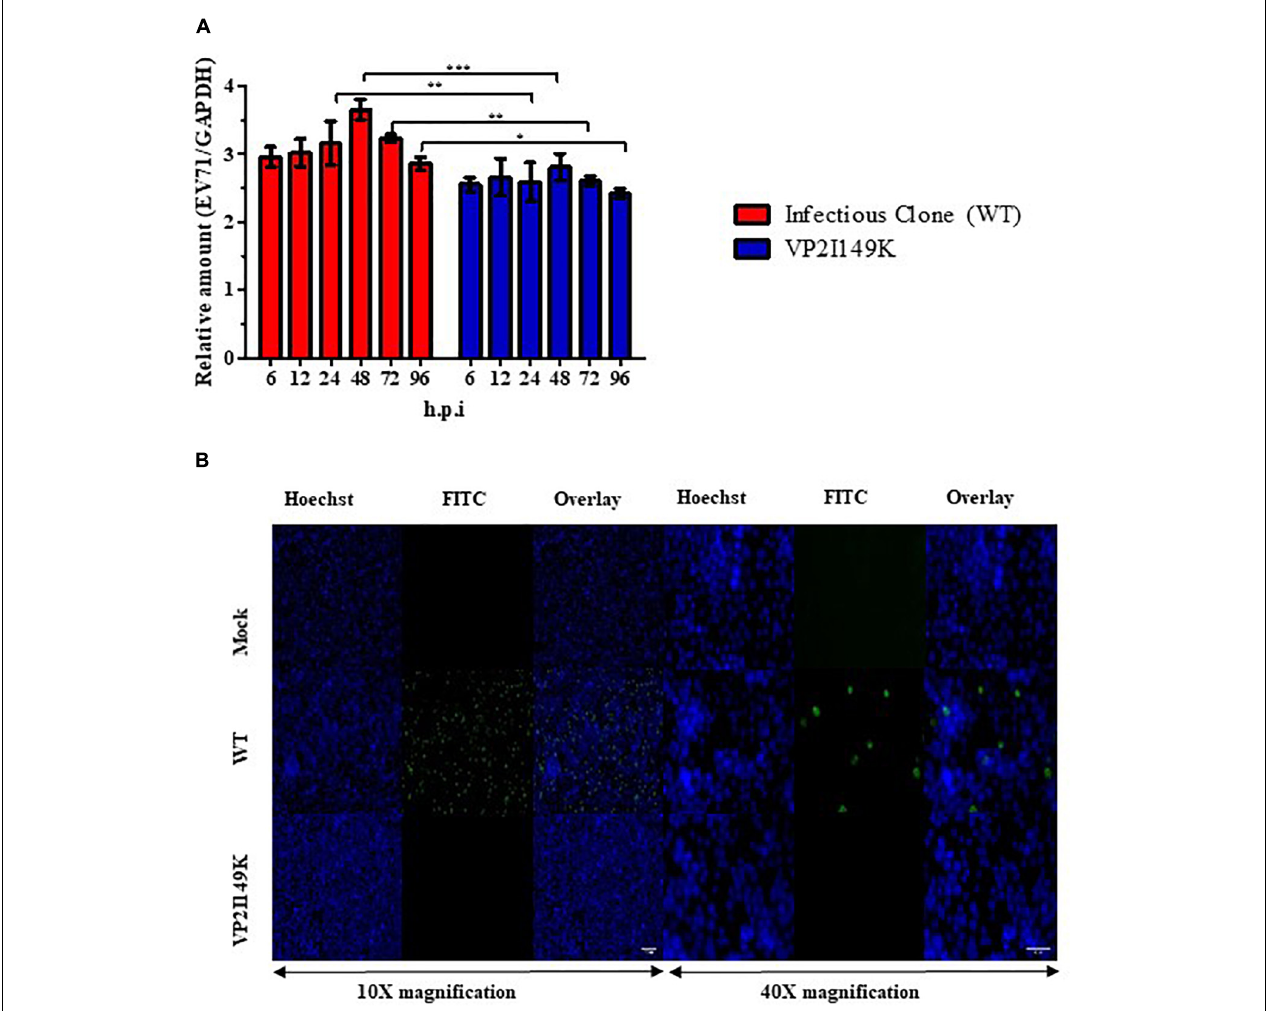
FIGURE 2 | Replication of VP2 I149K mutant in NSC-34 cells. (A) Quantification of intracellular viral RNA. NSC-34 cells were infected with VP2 I149K mutant or WT S41 strain at MOI of 10. At the indicated time-points, infected cells were harvested and viral RNA was extracted and quantified by RT-qPCR. Intracellular viral RNA levels ( Ct -values) were normalized to housekeeping GAPDH RNA levels. The fold change between infected vs. uninfected samples was calculated and data were expressed as the mean ± SD of technical triplicates. A two-way ANOVA with Bonferroni correction was used to evaluate statistical significance. * p < 0.05, ** p < 0.01, *** p < 0.001. One representative set of two independent experiments is shown. (B) Detection of dsRNA. NSC-34 cells were infected with WT S41 or VP2 I149K mutant at MOI of 10, or left uninfected (mock control). At 72 h.p.i, the cells were fixed and processed for immunostaining using antibodies specific to dsRNA (FITC green). Cell nuclei were stained with Hoechst 33342. The images were captured at 10 × or 40 × magnification. Representative images are shown. Scale bar denotes 100 and 40 µ m for 10 × or 40 × magnifications,